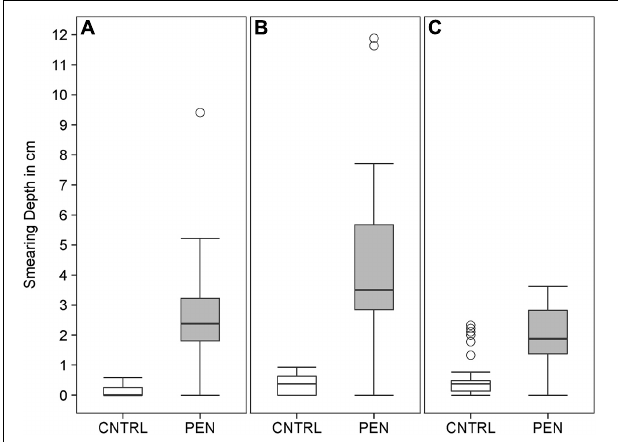
FIGURE 8 | The depth of luminophore smearing directly at the inserted plate for (A) mud and sand-like luminophores, (B) fine sand and sand-like luminophores, (C) and medium sand and mud-like luminophores in the control (CNTRL) and penetration (PEN) treatment. The box represents the interquartile range, the median is indicated by a line within the box. Whiskers indicate variability outside the interquartile range and circles indicate outliers.